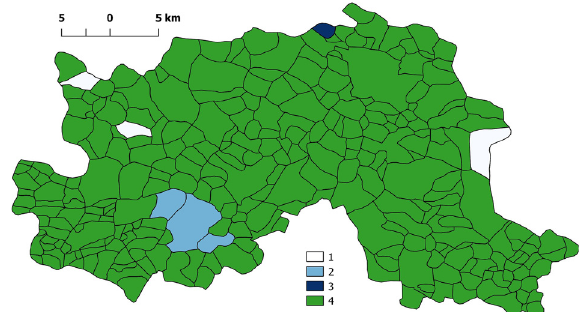
Fig. 5. Water Bodies Analysis for Gurugram district.